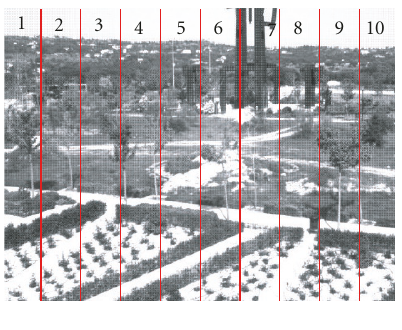
carrying out the other activity, a pedestrian approaches the shared area. The left agent is not aware of the approaching pedestrian, and goes on with its parallel task, as we have sup- posed there is no coordination between the two